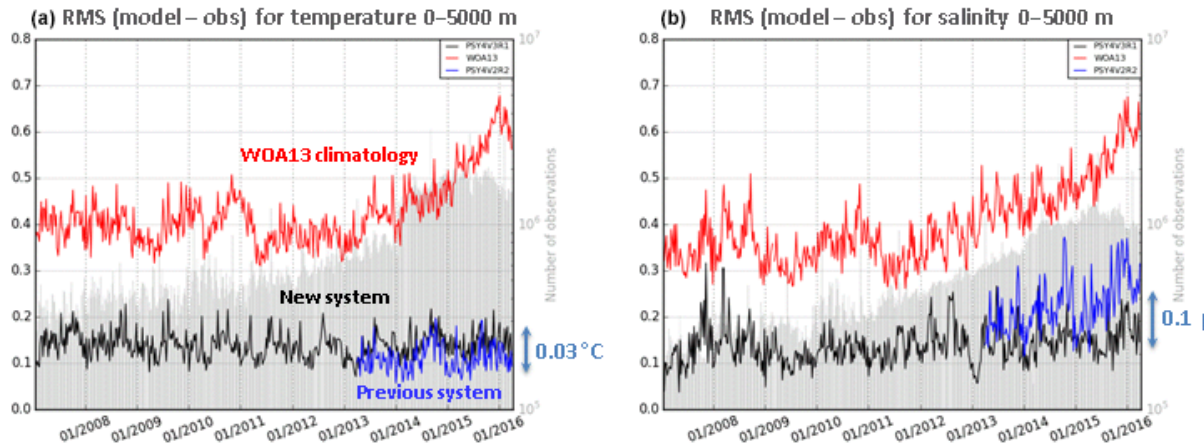
Figure 23. Time series of the 0–5000m RMS difference between the model analysis and the in situ observations for the previous system PSY4V2 (in blue), the new system PSY4V3 (in black) and the WOA13v2 climatology (in red). (a) Temperature (unit in ◦ C), (b) salinity (unit in psu). Time series of the number of available observations appear in